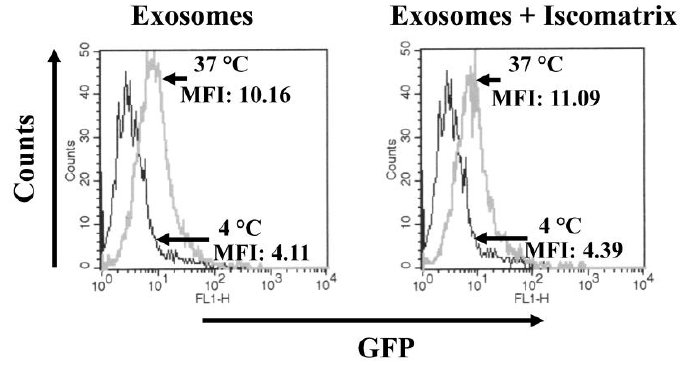
Figure 2. Unchanged cell internalization of exosomes in the presence of ISCOMATRIX TM adjuvant. A total of 2 × 10 5 B-LCLs were pre-treated for 2 h with bafilomycin A1 in the presence or not of the ISCOMATRIX TM adjuvant, and then challenged with 500 µU of fluorescent exosomes pre-incubated or not with the adjuvant. After spinoculation, the cells were incubated for an additional 2 h at either 4 or 37 °C in the presence of bafilomycin A1. Finally, cells were fixed and FACS analyzed. Fluorescence intensity of cells incubated at 4 °C was similar to that of untreated cells. Shown are the results representative of two independent experiments carried out with duplicates. Mean fluorescence intensity (MFI) of the samples are also indicated. Iscomatrix: ISCOMATRIX TM adjuvant.